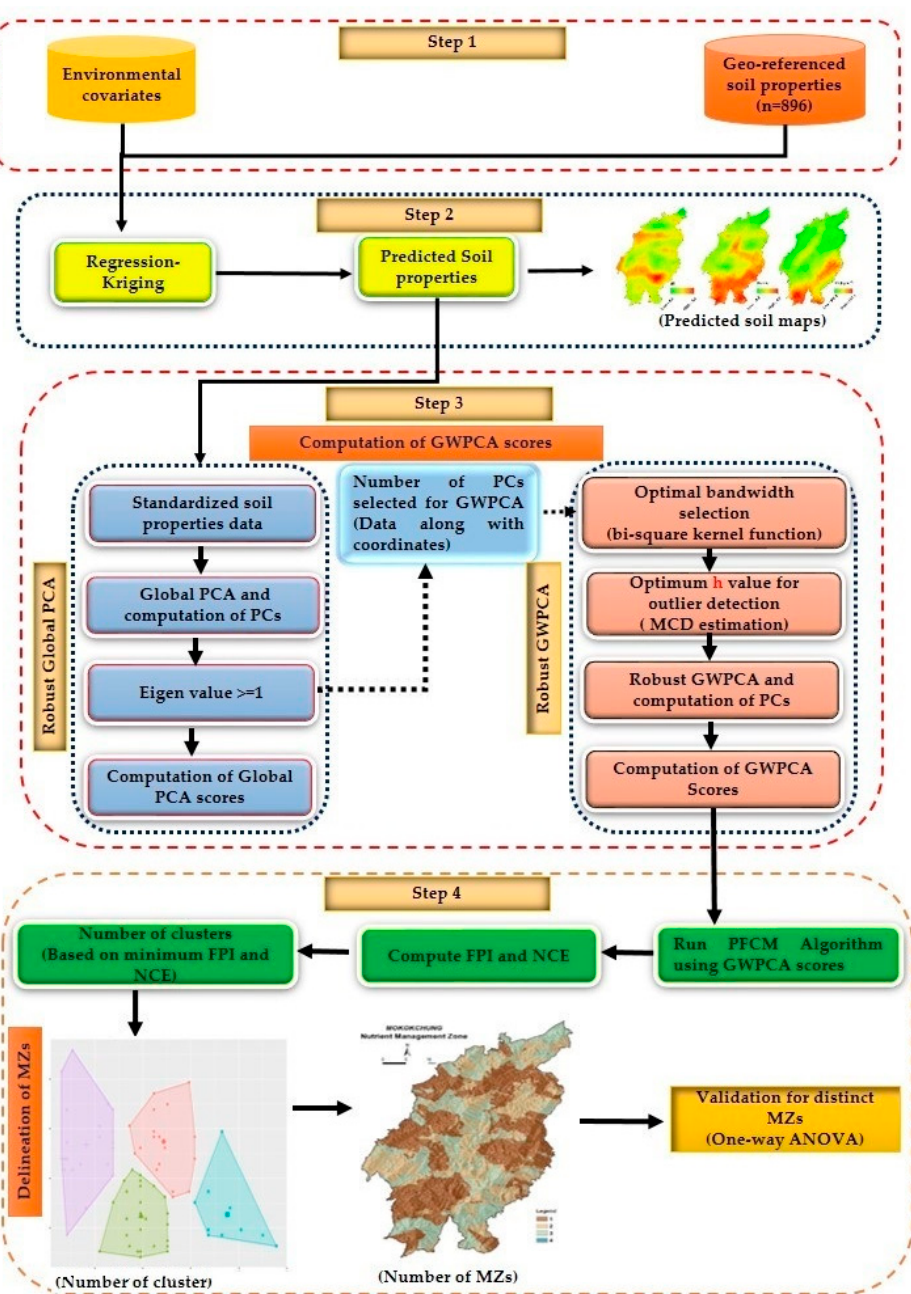
Figure 2. Methodology flowchart.